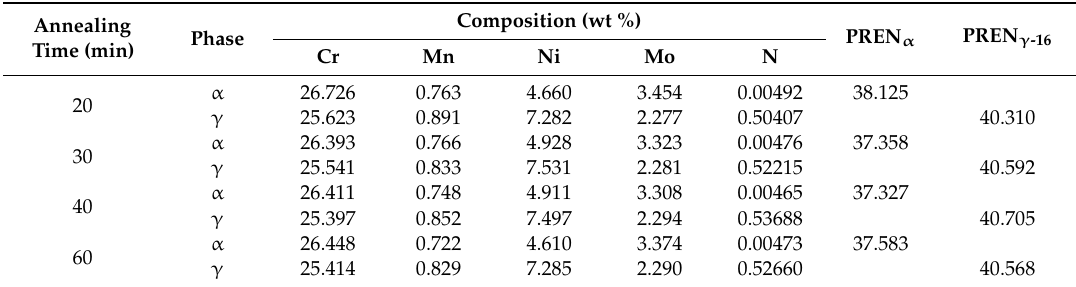
Table 2. Annealing time, element composition, and PREN values of the ferrite ( α ) and austenite ( γ ) phases of S32750 stainless steel annealed samples. PREN α = [Cr] + 3.3[Mo], PREN γ -16 = [Cr] + 3.3[Mo] + 16[N] – [Mn] [18].